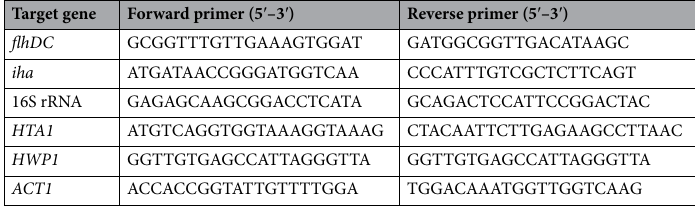
Table 2. flhDC , iha , 16S rRNA, HTA1 , HWP1 and ACT1 primer